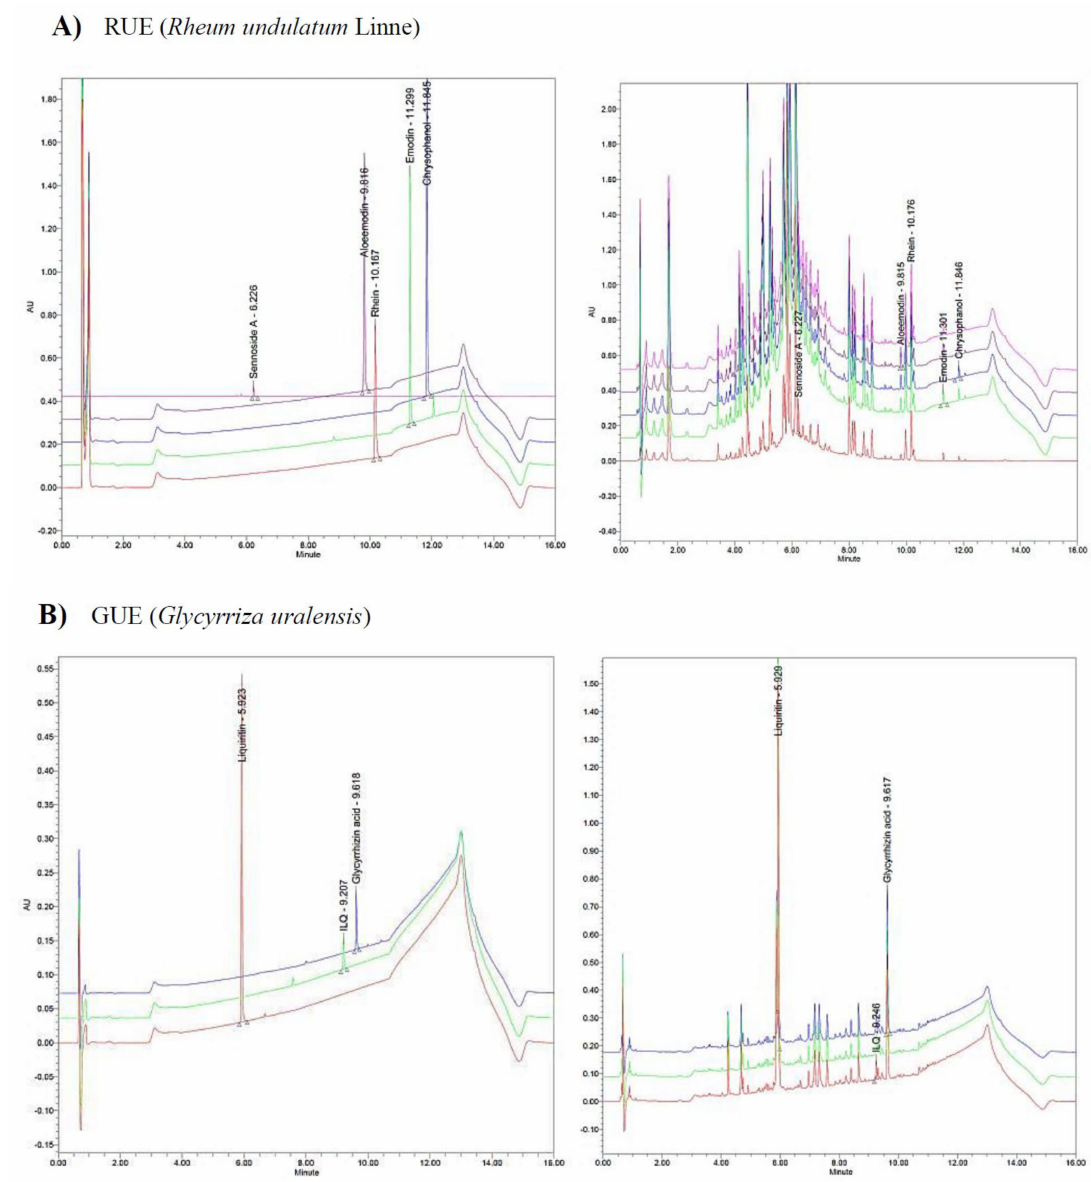
Figure 1. Characterization of RUE ( Rheum undulatum Linne) ( A ) and GUE ( Glycyrriza uralensis ) ( B ) by UPLC chromatogram. ( A ) UPLC chromatogram of five commercial standards (left) and marker compounds in GUE (right). Each peak represents sennoside A (340 nm), emodin (254 nm), chrysophanol (254 nm), aloe-emodin (254 nm), and rhein (254 nm), respectively. ( B ) UPLC chromatogram of theww commercial standards (left) and marker compounds in RUE (right). Each peak represents glycyrrhizin acid (254 nm), liquiritigenin (280 nm), and isoliquiritigenin (280 nm),